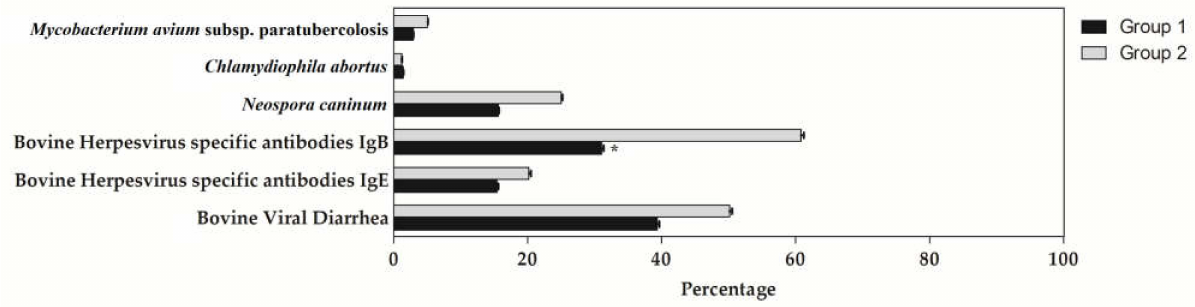
Figure 2. Mean ± standard deviations ( ± SD) of Mycobacterium avium subsp. paratuberculosis, Chlamydiophila abortus, Neospora caninum, bovine herpesvirus specific antibodies (IBR-gB and IBR-gE), bovine viral diarrhea virus in Group 1 (cows bred with extensive housing system) and Group 2 (cows bred with intensive housing system). * indicates statistical differences between the two groups ( p <